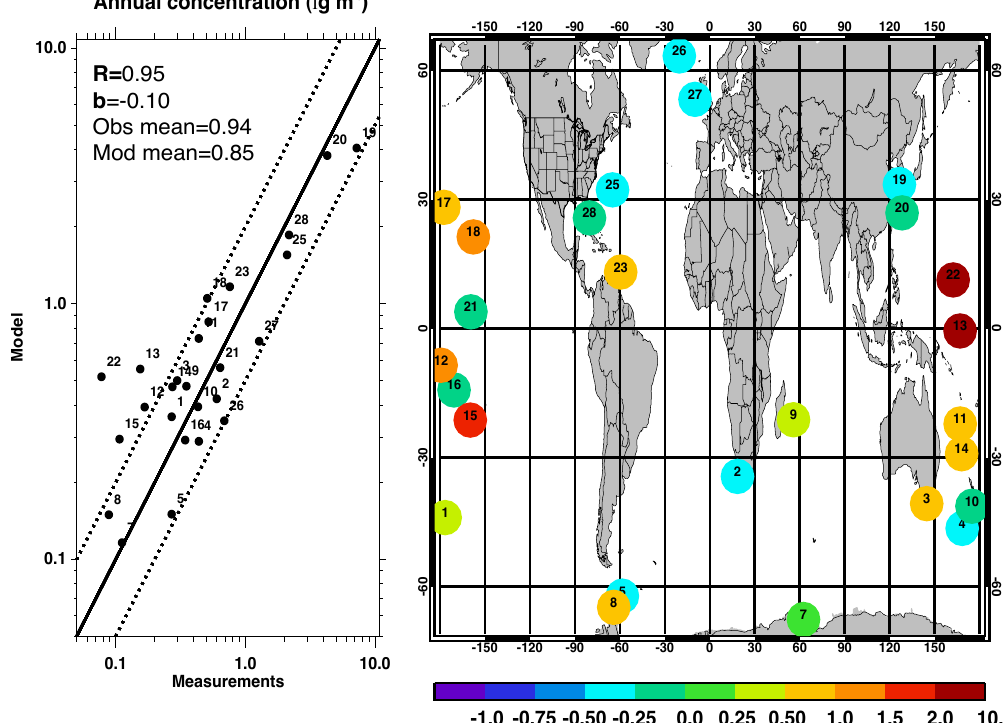
Fig. 10. Annual mean surface sulfate concentrations at the ocean network sites operated by the Rosenstiel School of Marine and Atmospheric Science (RSMAS) at the University of Miami (Arimoto et al., 1996; Prospero et al., 1989; Savoie et al., 1993, 1989). The left panel shows the scattering plot between the observations and the model. Model mean (“Mod mean”), observational mean (“Obs mean”), normalized model mean bias (“b”) and the correlation coefficient between model and observations (“R”) are shown. The right panel shows the global map of individual sites, and the relative difference between the model and the observations: